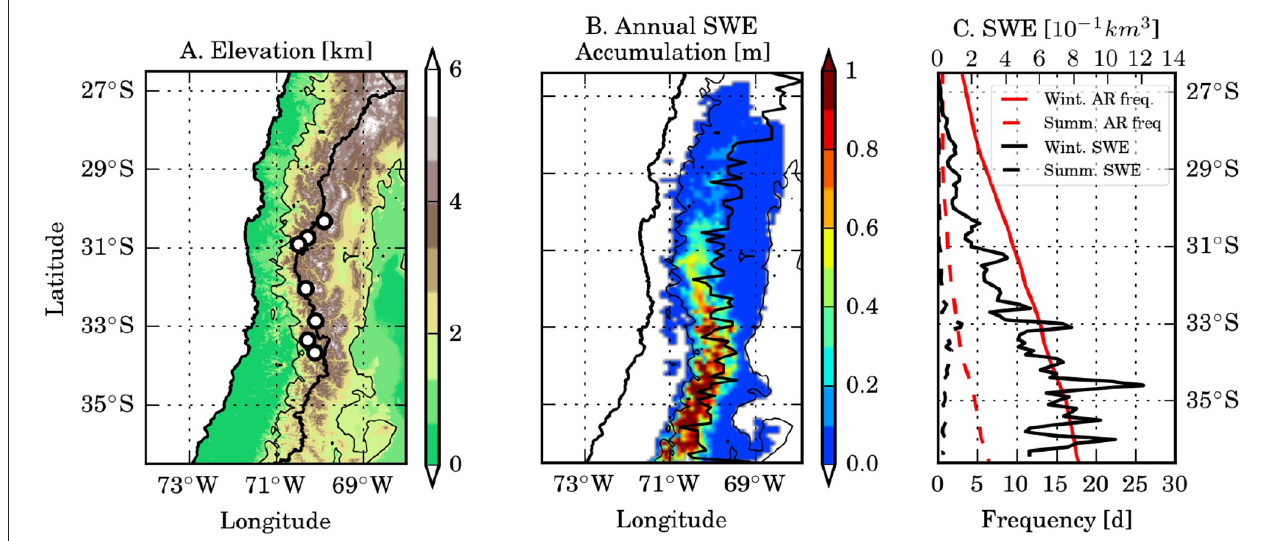
FIGURE 1 | (A) Topographic map of the Subtropical Andes. Surface snow measurement sites are indicated by white circles and the thick black lines indicate the border between Argentina and Chile and the coastline, while the thin black line indicate the 2,000 m elevation for reference. (B) Climatology of the Snow Water Equivalent (SWE) derived from the snow reanalysis over the 1984–2014 period [adapted from Cortés and Margulis (2017)]. Black thick lines show the coast line and the crest of Andes (maximum altitudes in snow reanalysis dataset); the 2,000 m elevation line is also indicated. (C) Variations with latitude of the Atmospheric River frequency along the Pacific coast (red lines) and of the areal mean SWE (black lines) for winter (Apr-Sep) and summer (Oct-Mar) seasons (continuous and dashed lines,